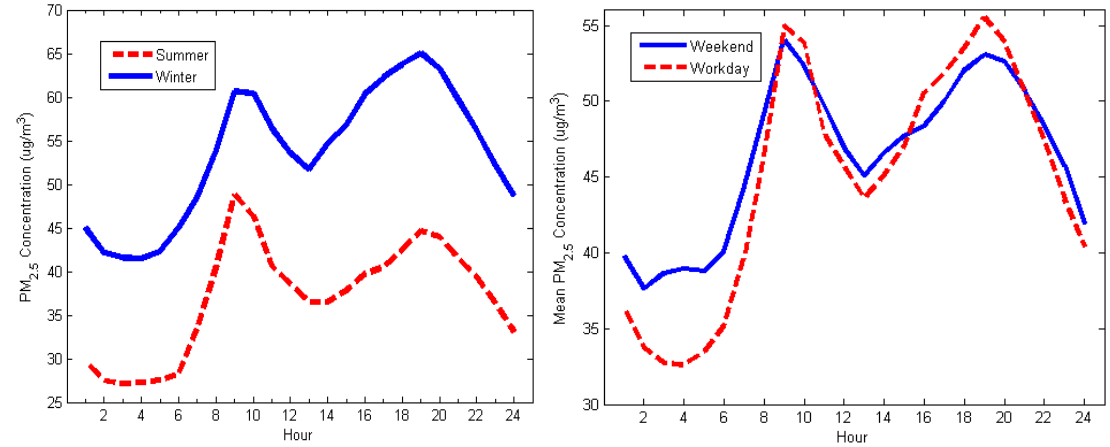
Figure 4. Diurnal trends of PM ( right ) during weekend and weekday.